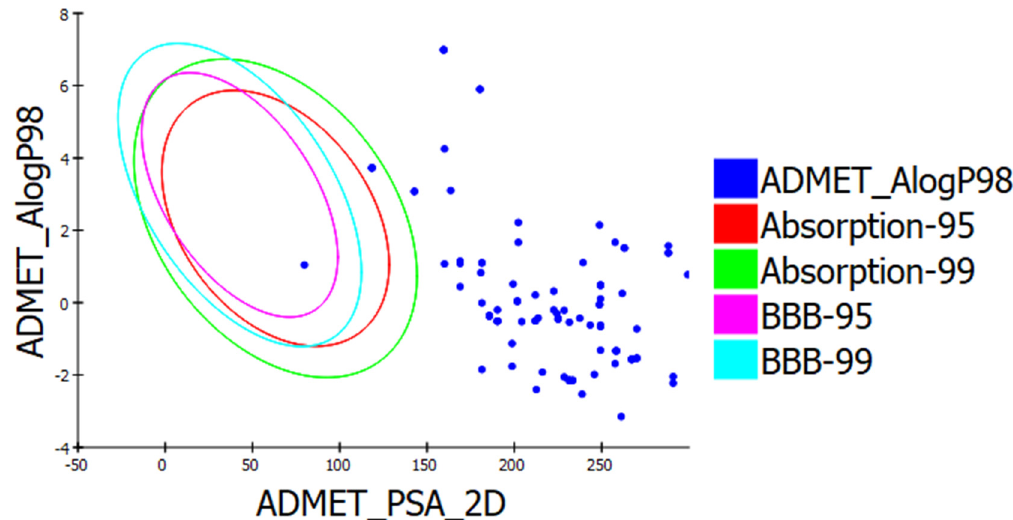
Figure 4. ALogP versus polar surface area (PSA) plot for Shikonin pharmacophores showing the 95% and 99% confidence limit ellipse corresponding to the blood-brain barrier (BBB) and intestinal absorption. Table 1. Computational parameters of pharmacokinetics (ADME) of Shikonin pharmacophores as calculated by the ADMET